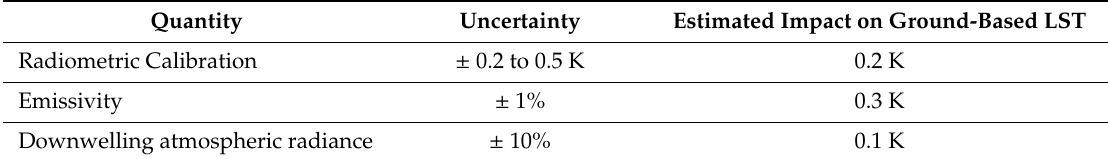
Table 8. A literature example showing the impact of the parameter uncertainty ranges on ground-based LST, from